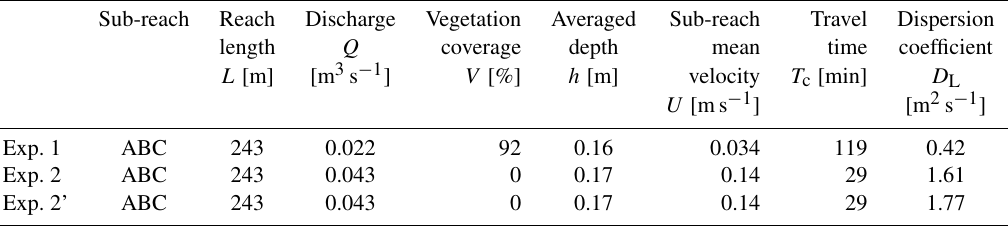
Table A1. Hydraulic, vegetative and mixing parameters of the sub-reach between the P1 and P4 cross-sections during the experiments in vegetated (Exp. 1) and in fully cut conditions – original (Exp. 2) and repeated experiment (Exp. 2’). Sub-reach Reach Discharge Vegetation Averaged Sub-reach Travel Dispersion length Q coverage depth mean time coefficient L [ m ] [ m 3 s − 1 ] V [ % ] h [ m ] velocity T c [ min ] U [ ms − 1 ] Exp. 1 ABC 243 0.022 Exp. 2 ABC 243 0.043 0 Exp. 2’ ABC 243 0.043